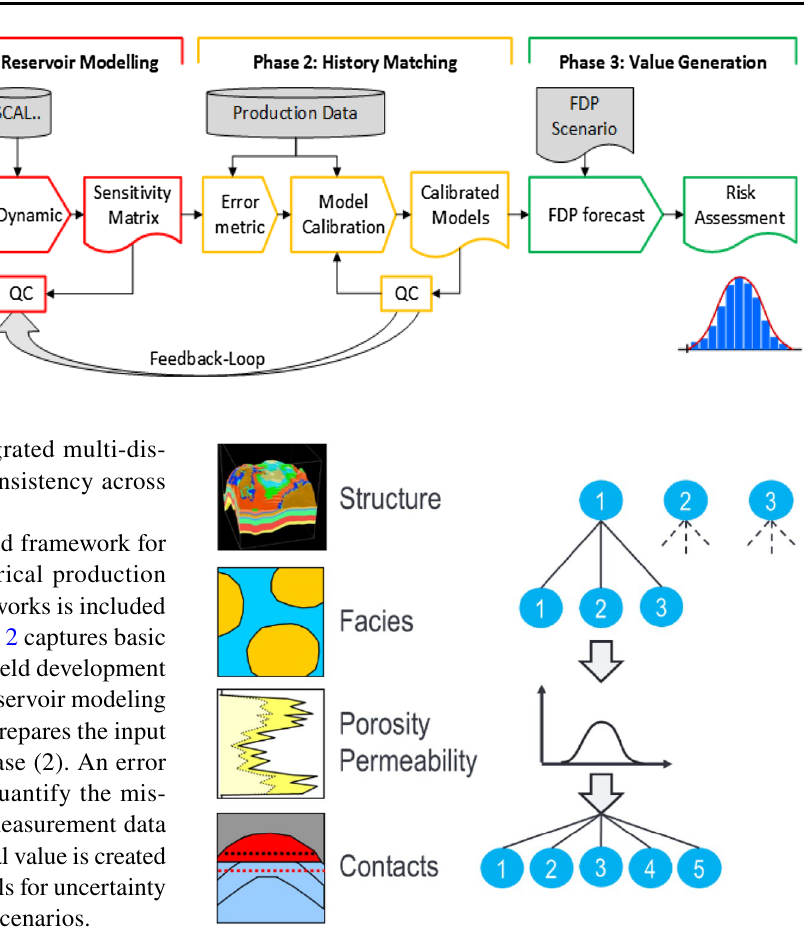
Fig. 3 Hierarchy of input parameters and resultant volumetric cases created